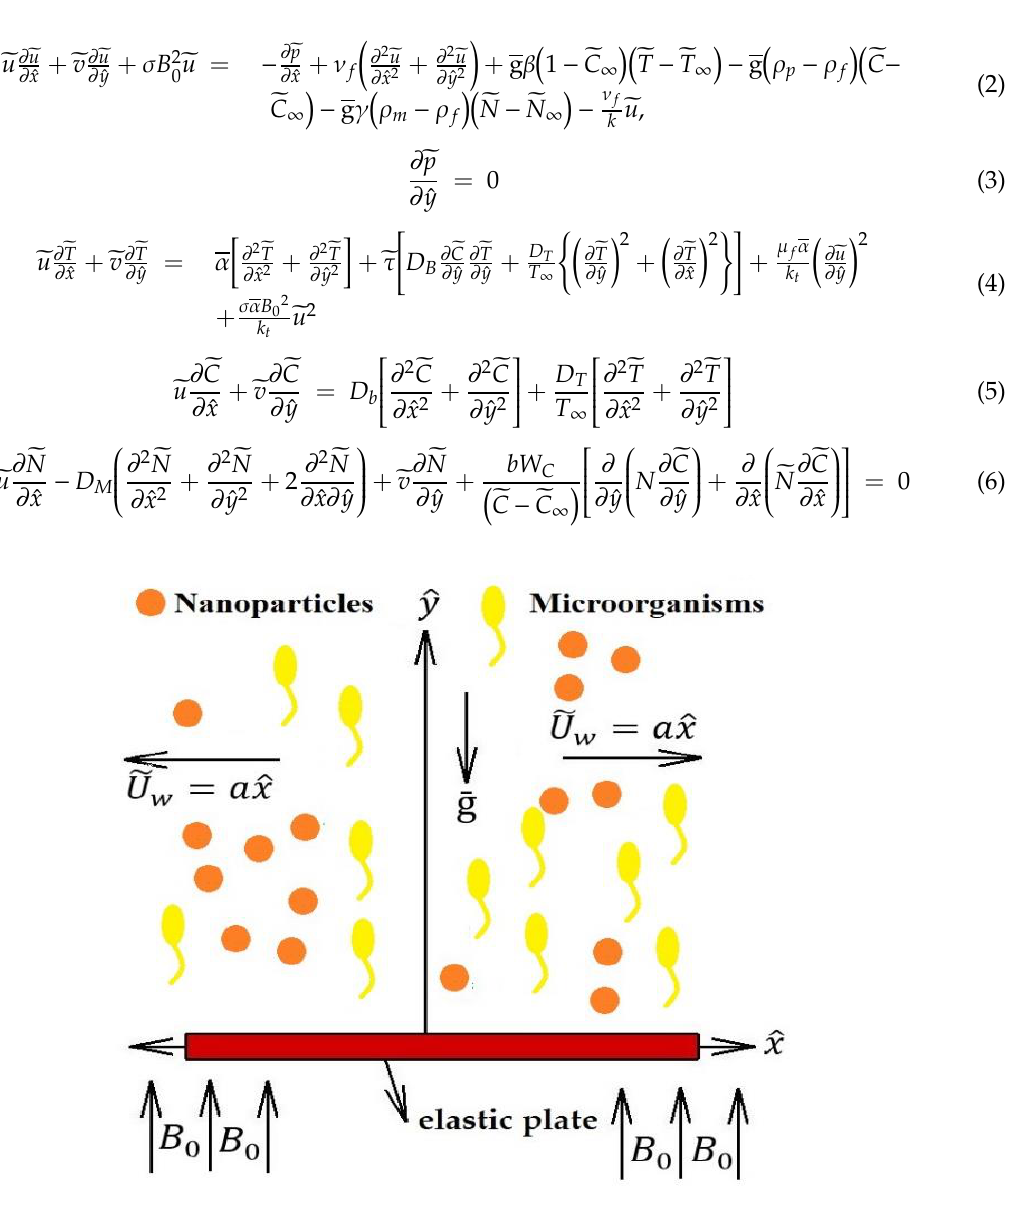
Figure 1. Flow structure through a stretch elastic plate.